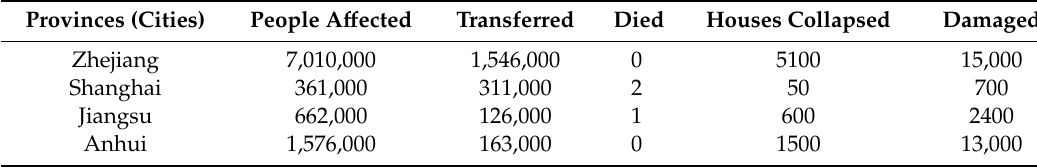
Table 1. Statistics of losses caused by typhoon anemone